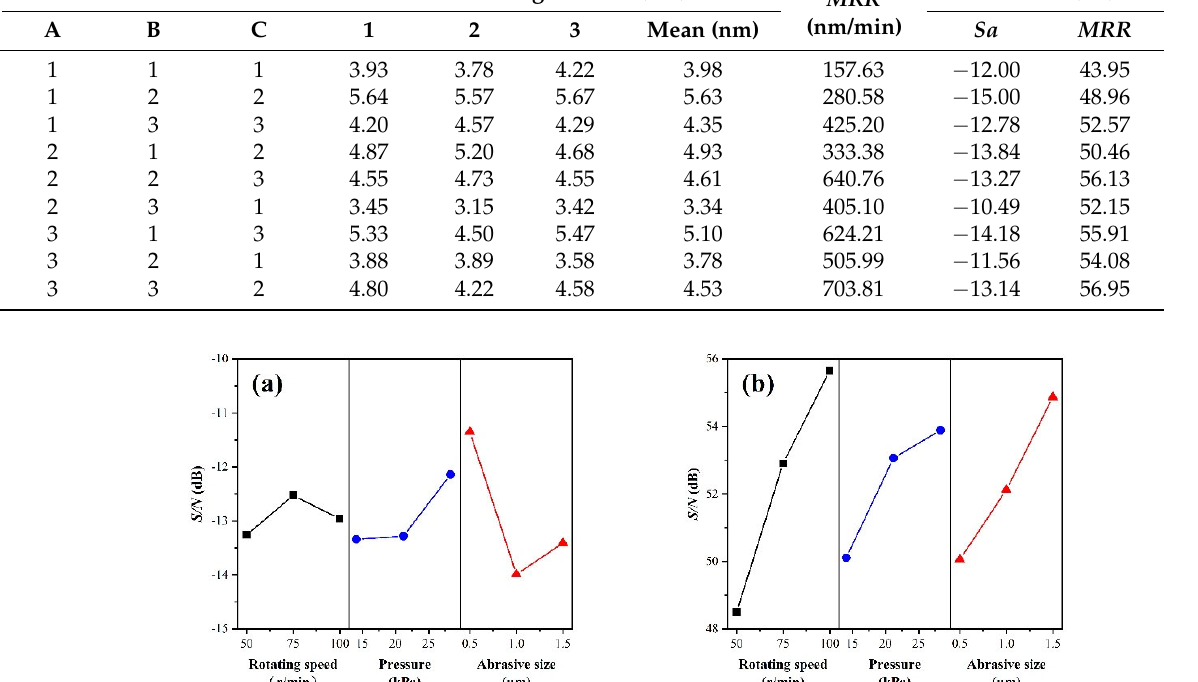
Table 3. Experimental results of the surface roughness, material removal rate and S / N values. Experiment.